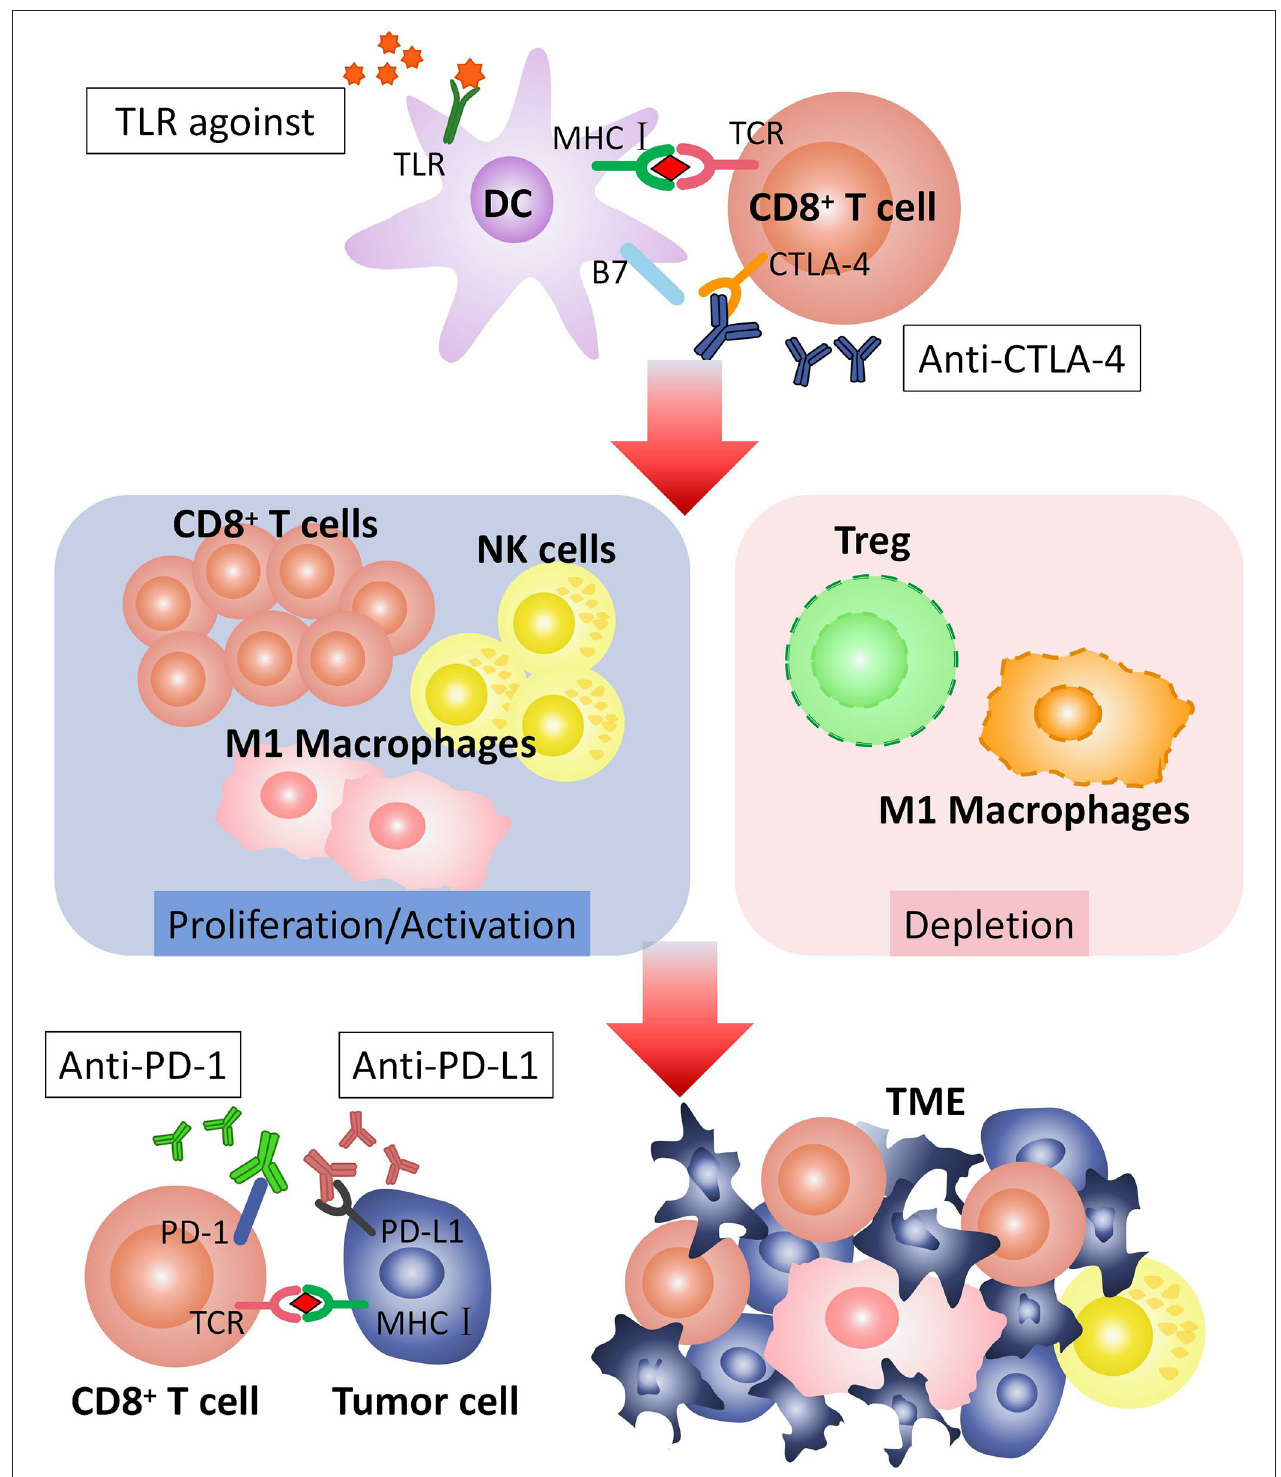
FIGURE 2 | How TLR agonist promotes the efficacy of checkpoint blockade therapy. CTLA-4 is expressed on the surface of CD8 + T cell, combining with B7 on dendritic cells (DCs), to regulate T cell responses. CTLA-4 pathway can be blocked by anti-CTLA-4 antibodies. TLR agonist activates TLR on DC. Activated TLRs pathway can induce proliferation or activation of CD8 + T cells, M1 macrophages and NK-cells, and depletion of M2 macrophages and Tregs. CD8 + T cells, M1